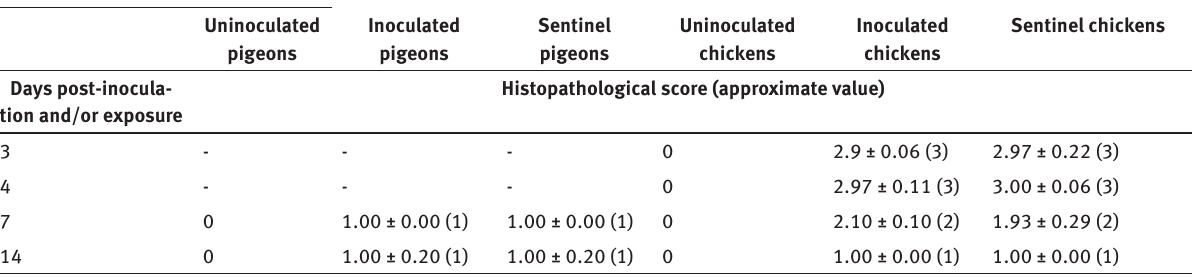
Table 4: Histopathological score in pigeons and chickens following inoculation with and/or exposure to a very virulent infectious bursal disease virus